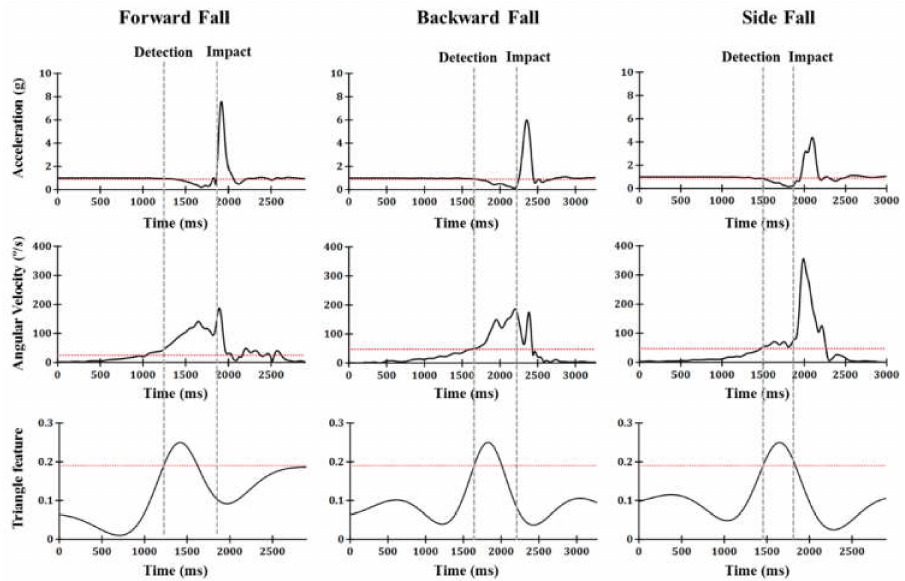
Figure 4. ( top ) Acceleration, ( middle ) angular velocity, and ( bottom ) triangle feature data during falls.